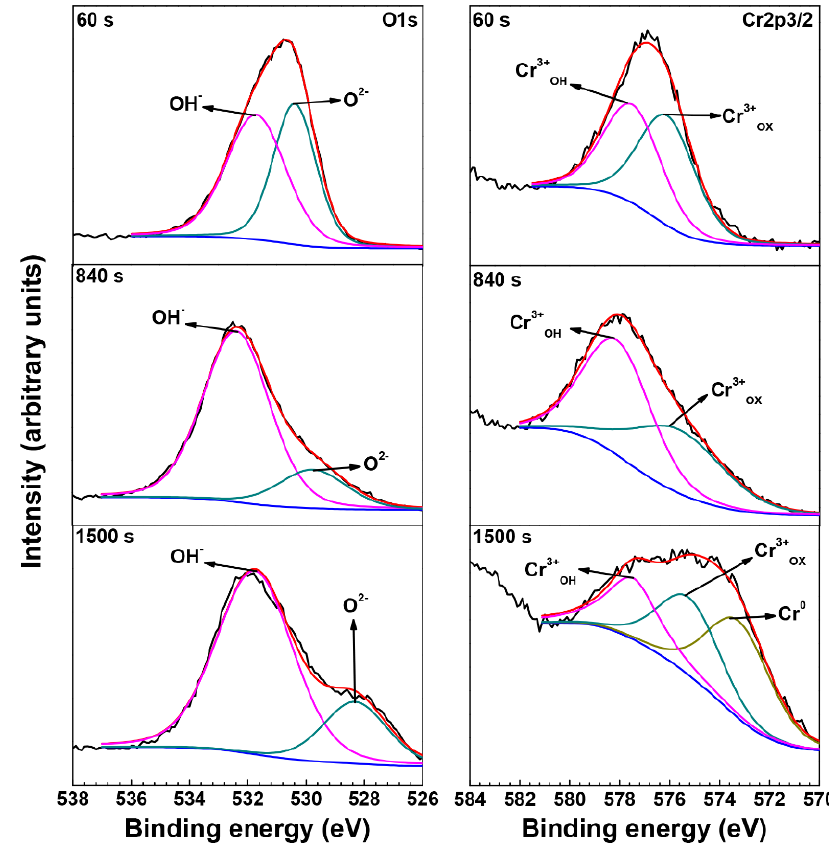
Figure 8. The O 1s and Cr 2p3/2 core lever spectra inside the crevice of the crevice sample exposed to 290 °C NaCl solution.